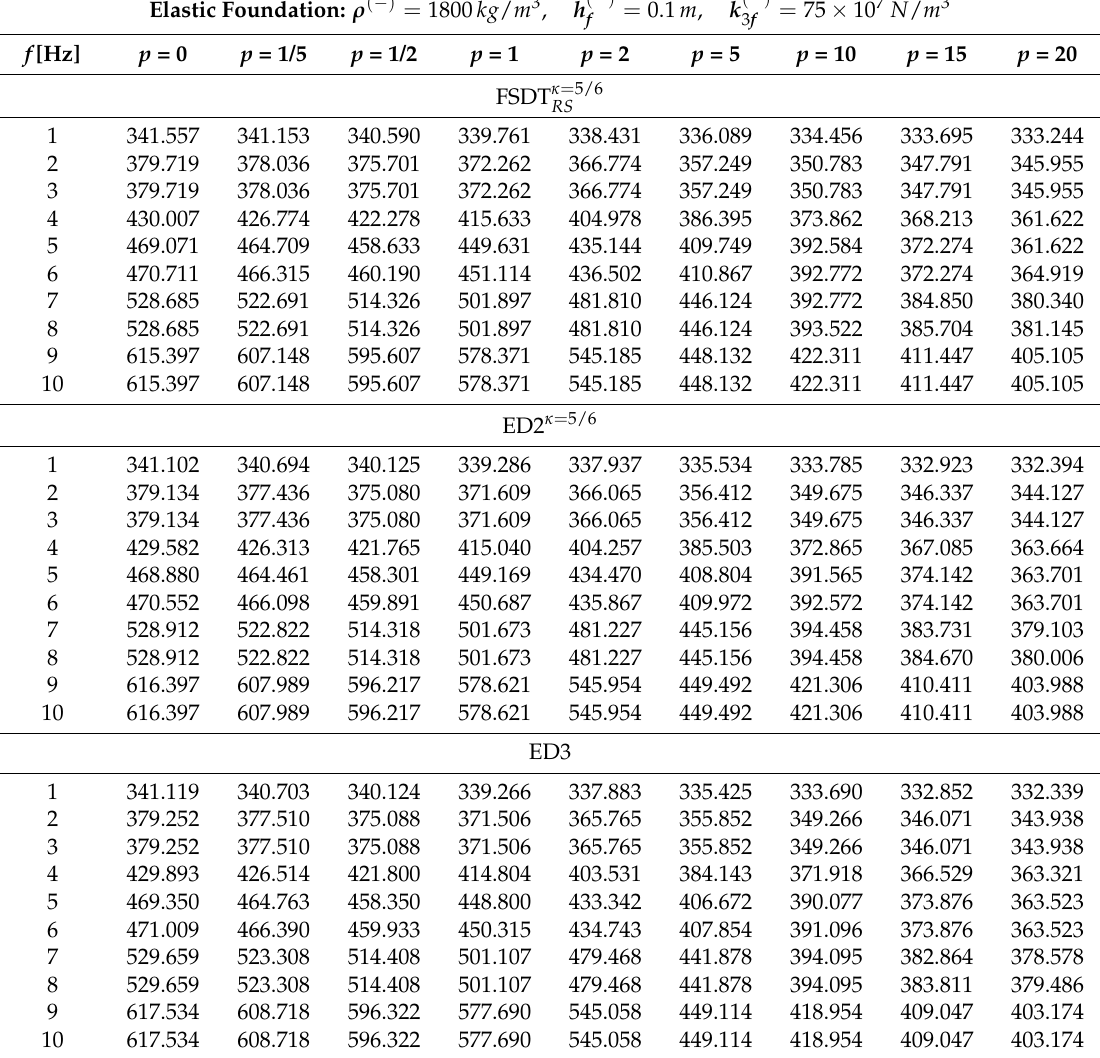
Table 4. First ten natural frequency variations of a CCCC square plate (Figure 4a) made of one